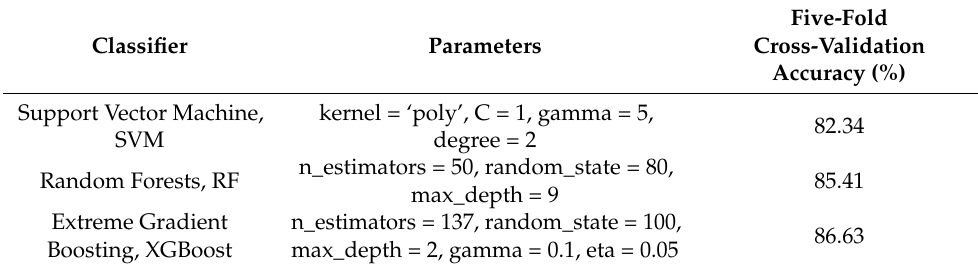
Table 2. Parameters of the SVM, RF, and XGBoost models.